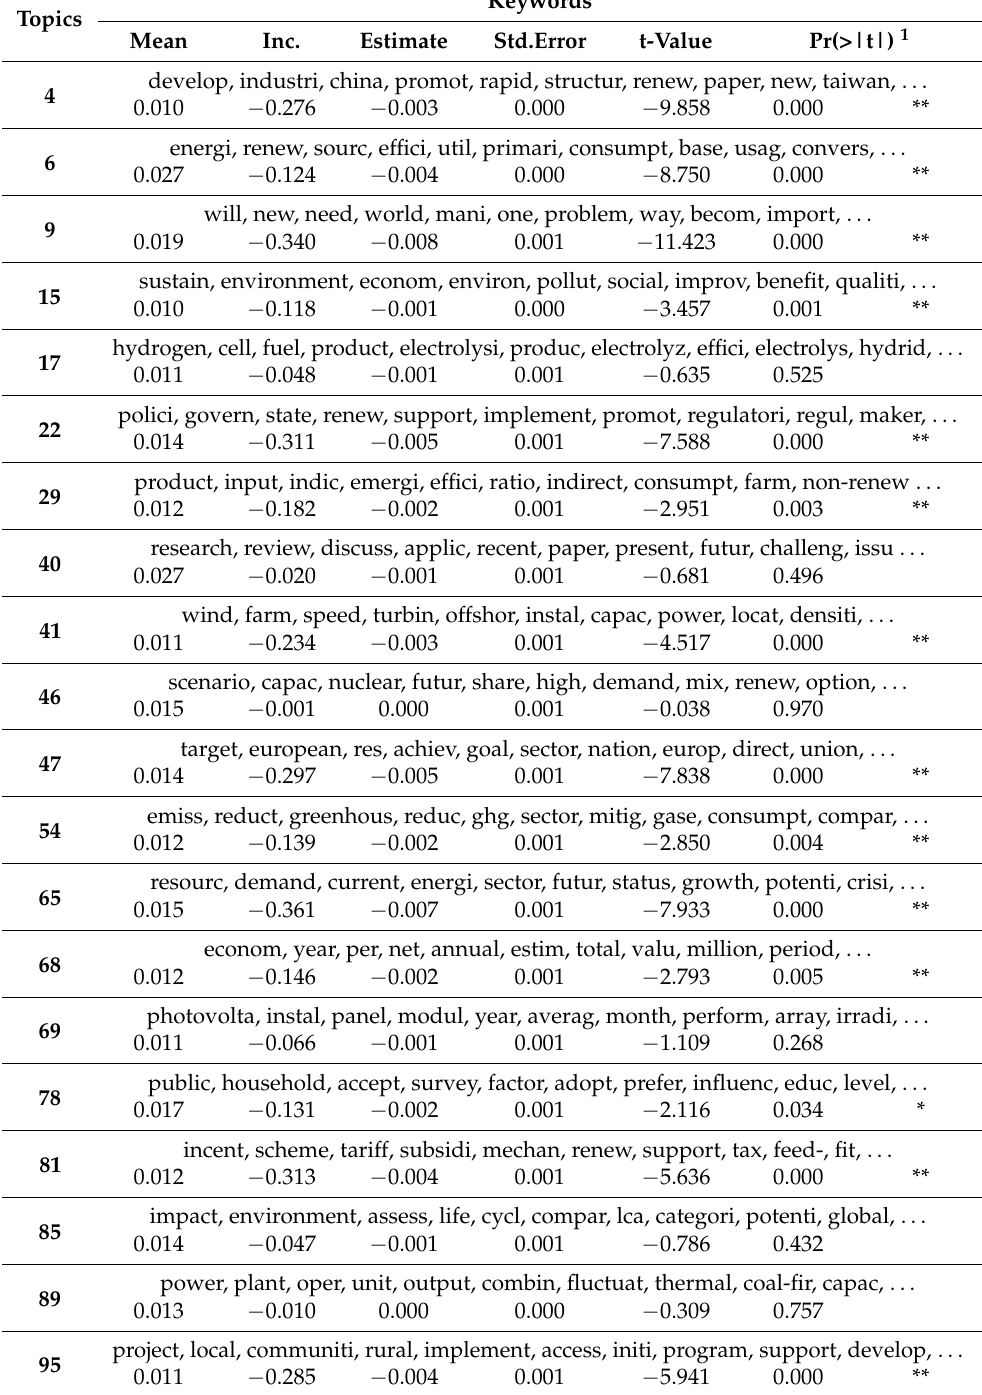
Table 7. Topics selected as not-strong-but-well-known (NSWK) signals.